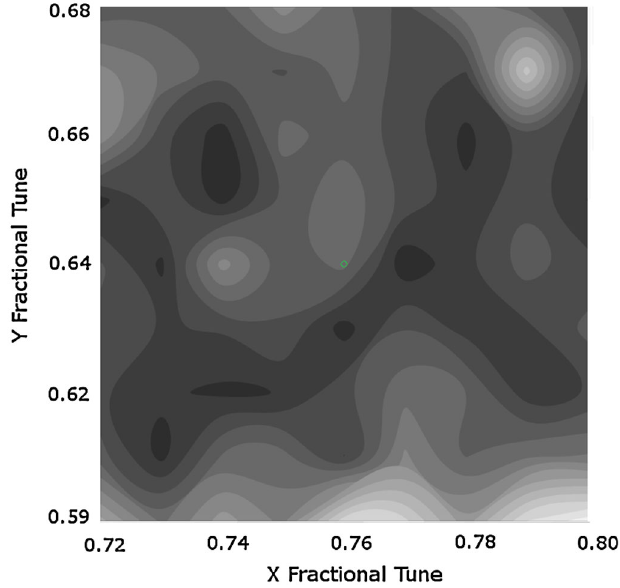
FIG. 13. A contour plot of the average standard deviation for 100 different sets of magnet current offsets. The darker areas show a smaller standard deviation of offset, which means they are less sensitive to errors. The green e symbol represents the location of the ideal